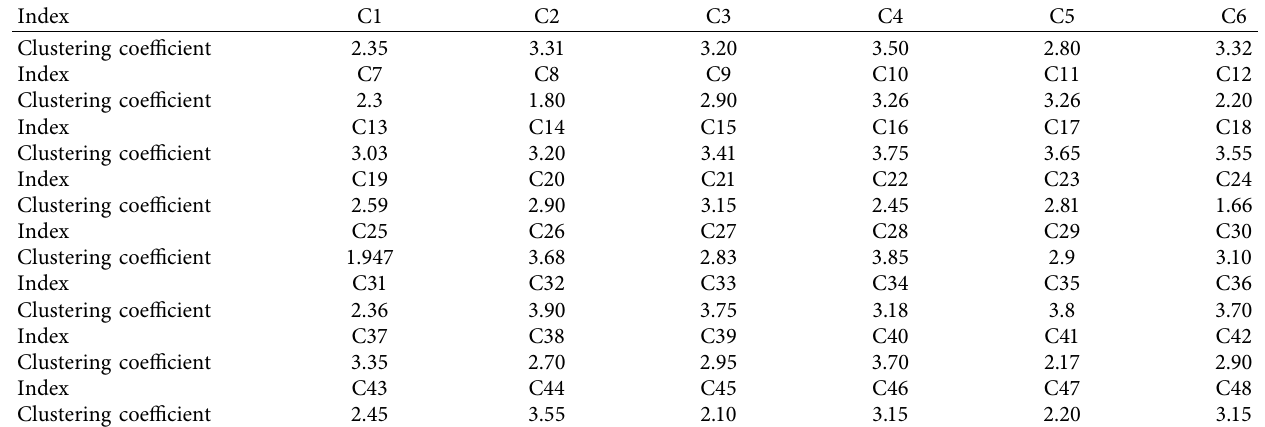
Table 6: Clustering coefficients for each of the three levels of indicators.